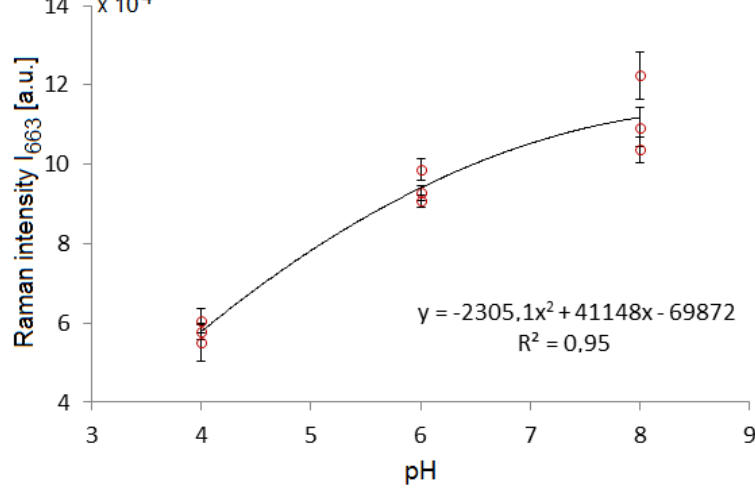
Figure 10. The pH dependence of the SERS signal from 10 mM TCP on SK307 substrate. We used data from 3 subsequent cycles of pH changes to plot the dependence. The regression curve approximates the relation between pH and the SERS signal. Each data point was averaged from 6 measurements. Error bars: 95% confidence interval.